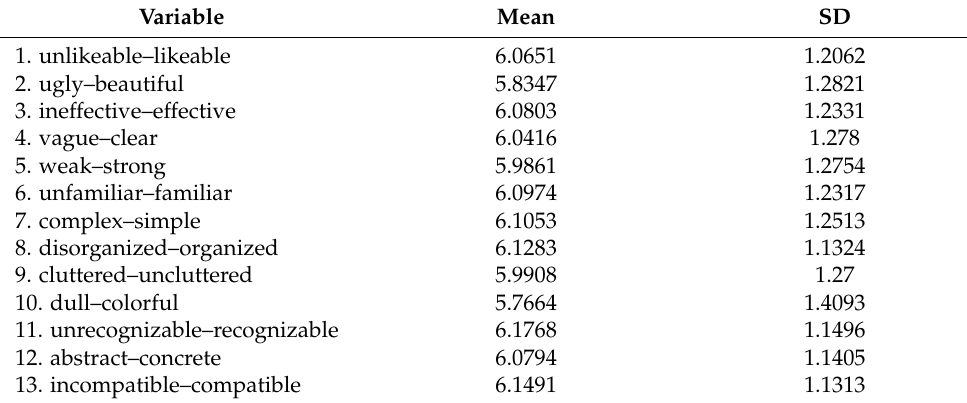
Table 6. Descriptive statistics: semantic